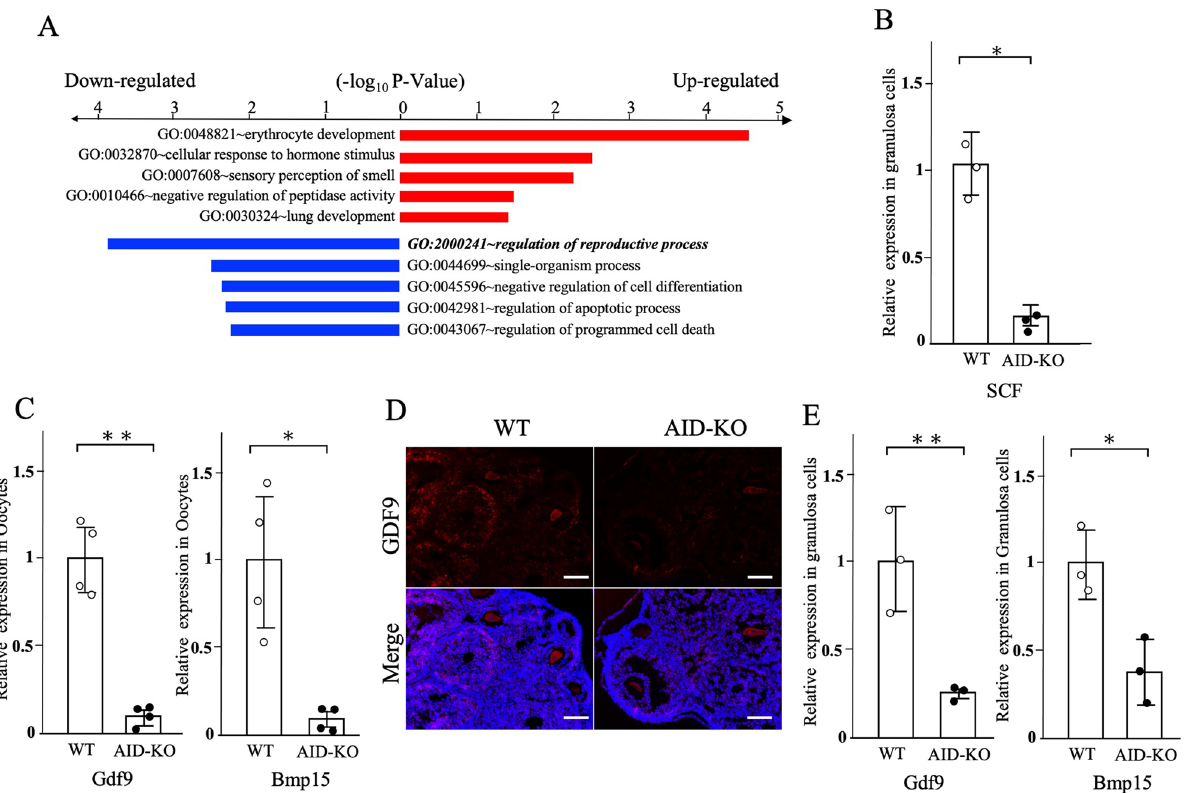
Figure 3. Analysis of GDF-9 and SCF expression in the follicles of AID-KO mice. ( A ) Gene ontology analysis of microarray study. Top 5–7 gene-ontology biological process terms with threshold set at a P-value < 0.05 from up- and down-regulated genes. ( B ) RT-qPCR showed the reduction of mRNA expression of SCF in granulosa cells derived from the AID-KO mouse. Gene expression of Gapdh was used as a control for qPCR analysis. ( C ) RT-qPCR showed that the mRNA expressions of GDF-9 and BMP-15 in oocytes were decreased in oocytes derived from the AID-KO mouse. ( D ) Immunohistological examination showed that the protein expression of GDF-9 was detected in oocytes and granulosa cells in 3-week-old mouse ovaries, whereas its expression was reduced in the AID-KO mouse. Bars show 100 μm. ( E ) RT-qPCR showed that the mRNA expressions of GDF-9 and BMP-15 in granulosa cells were decreased in oocytes derived from the AID-KO mouse. *P < 0.05; **P <